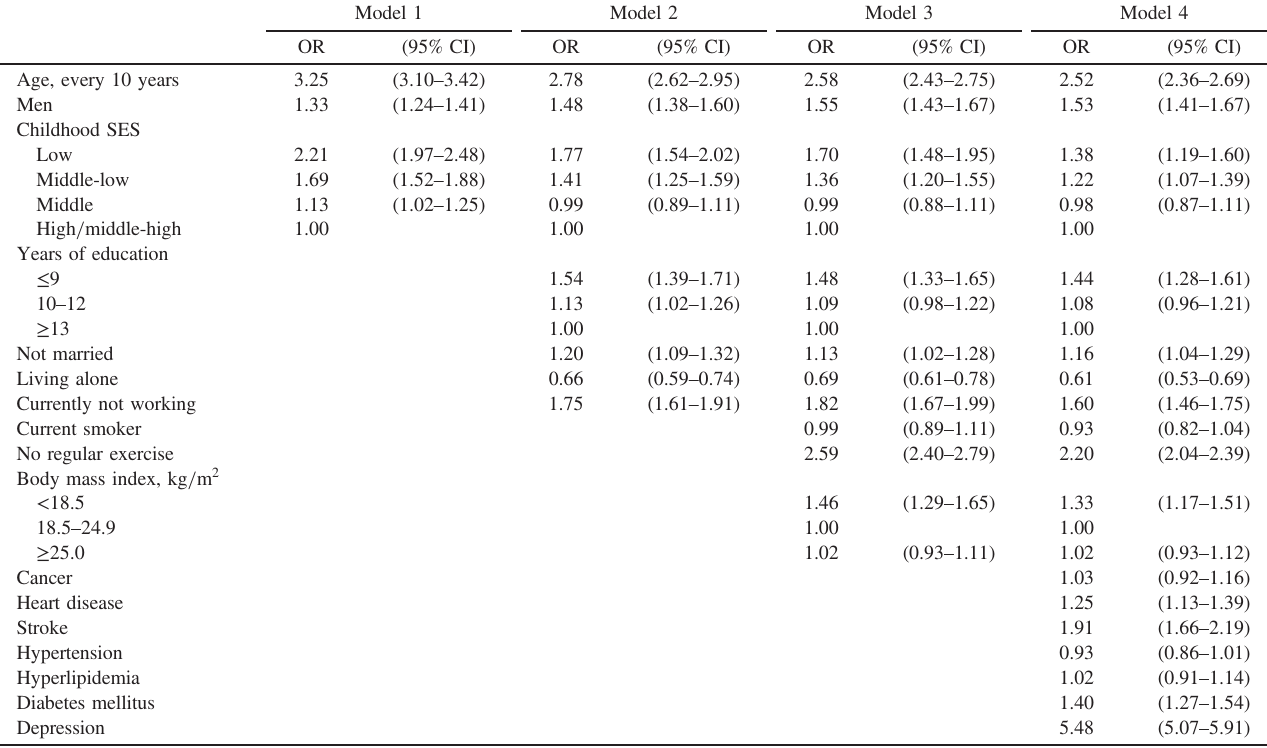
Table 2. Associations between childhood socioeconomic status and subjective dementia